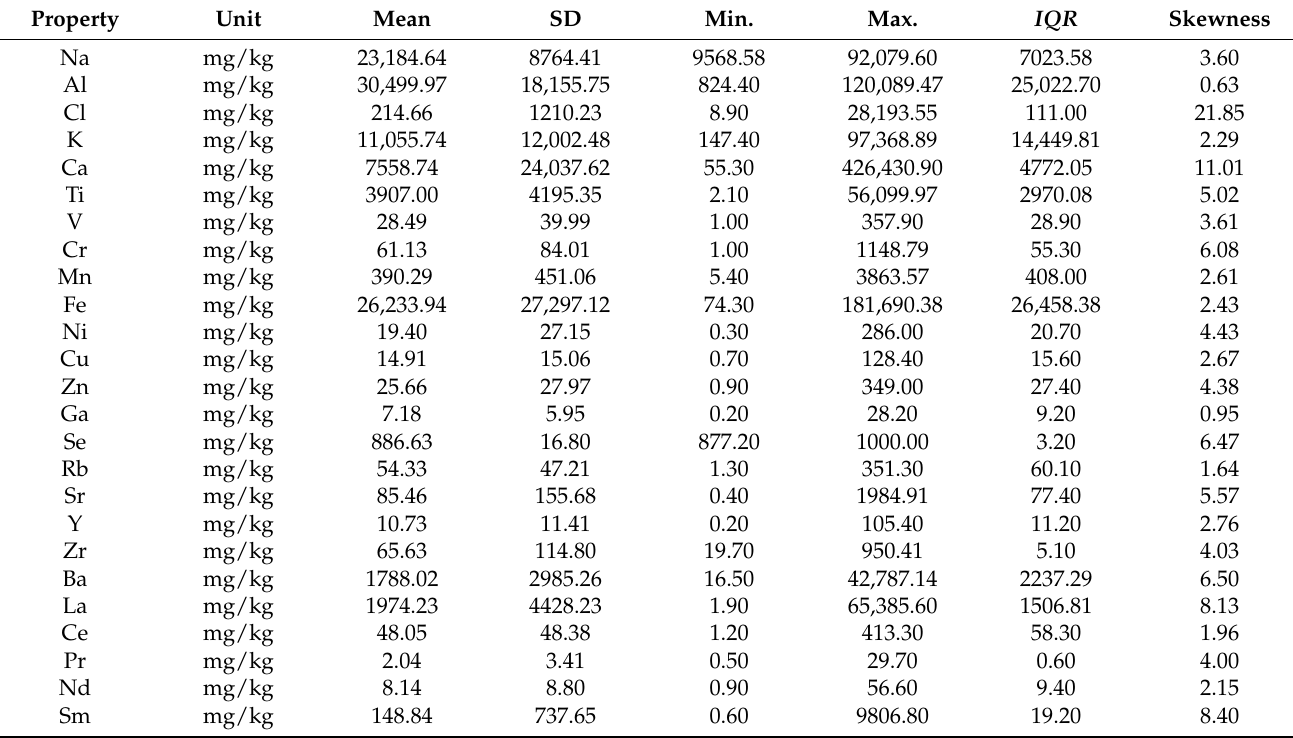
Table A4. Descriptive statistics of properties in the “Elements”